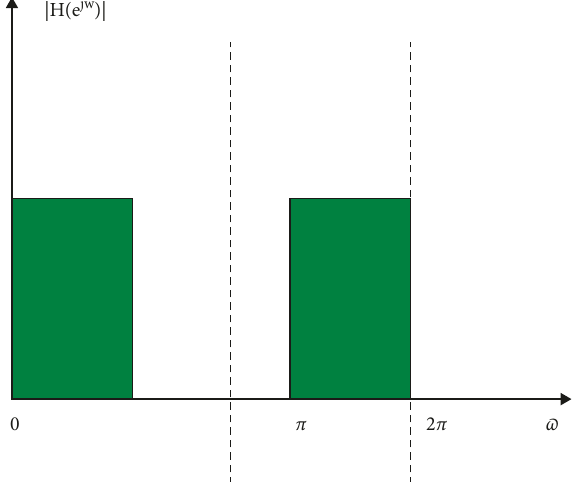
Figure 4: Ideal characteristics of a low-pass filter.